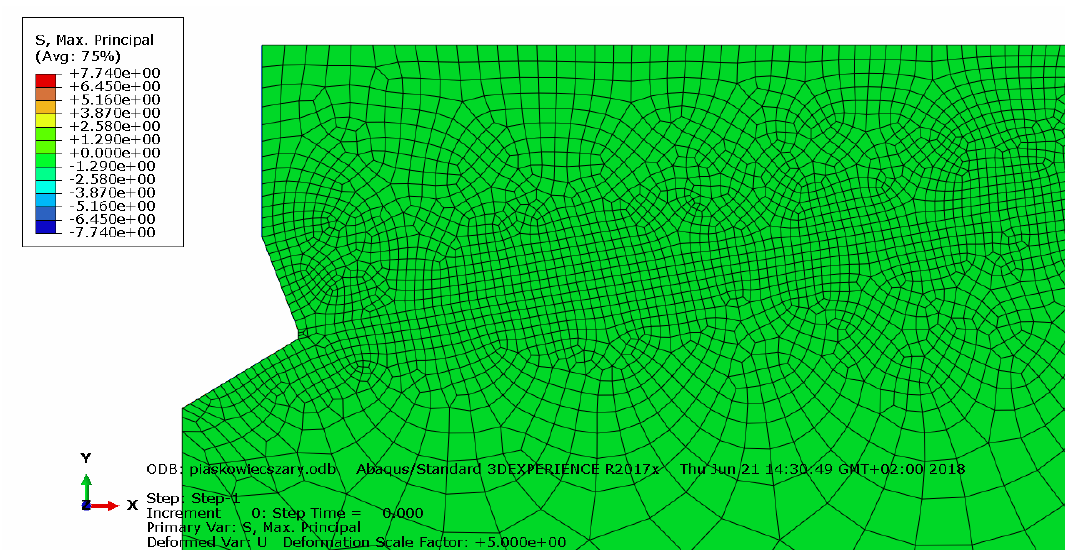
Figure 9: Model of the test before the load